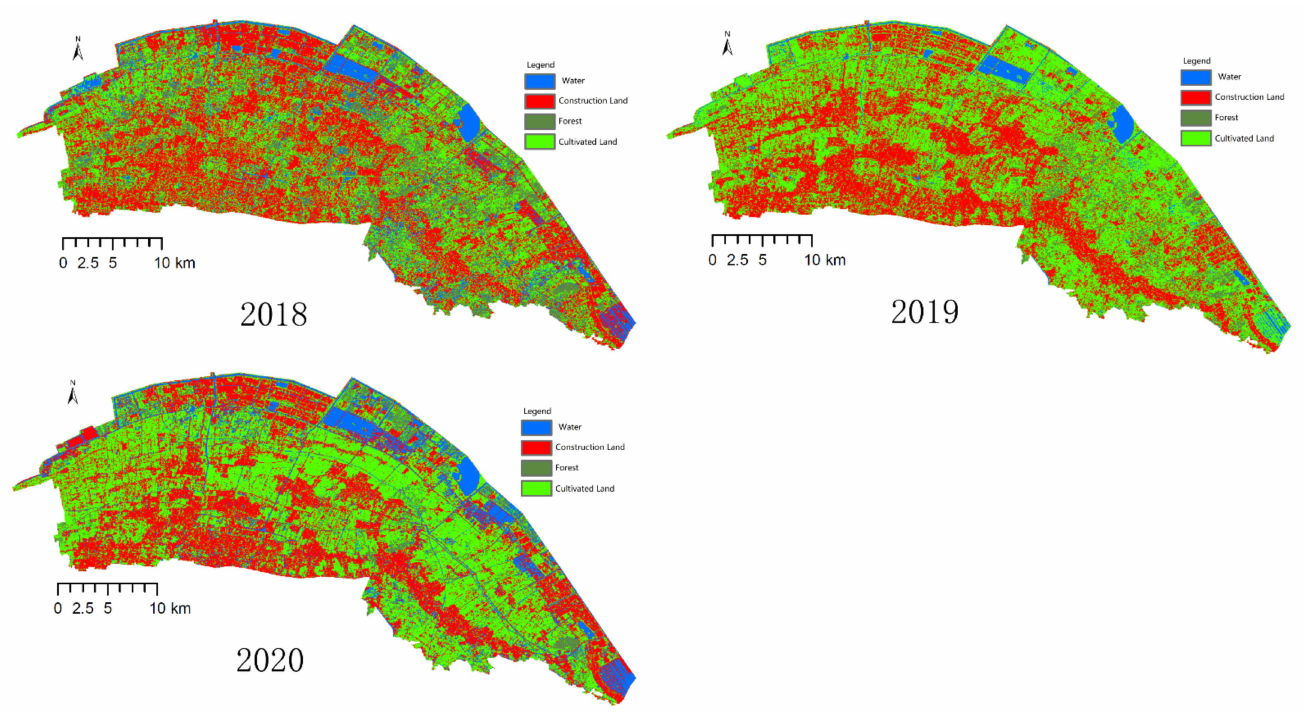
Figure 4. The land-use/land-cover contribution of the research area (2018 to